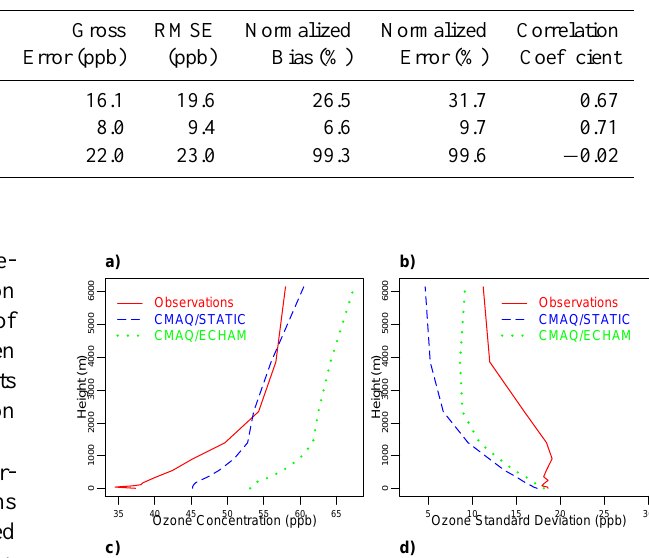
Table 5. Model performance metrics calculated for the CMAQ/ECHAM5-MOZART simulated daily maximum 8-hr ozone concentrations at 90 monitors for 1988–2005. Metrics for the “All days” row were calculated using all observed and simulated values for May–September for each year. Metrics for the 5th and 95th percentile rows were calculated by first determining the corresponding percentile from the 153 daily May–September values for each year and then calculating the metrics across the 18 years from 1988–2005. All metrics were calculated separately at each monitor and then averaged for display in this Table.